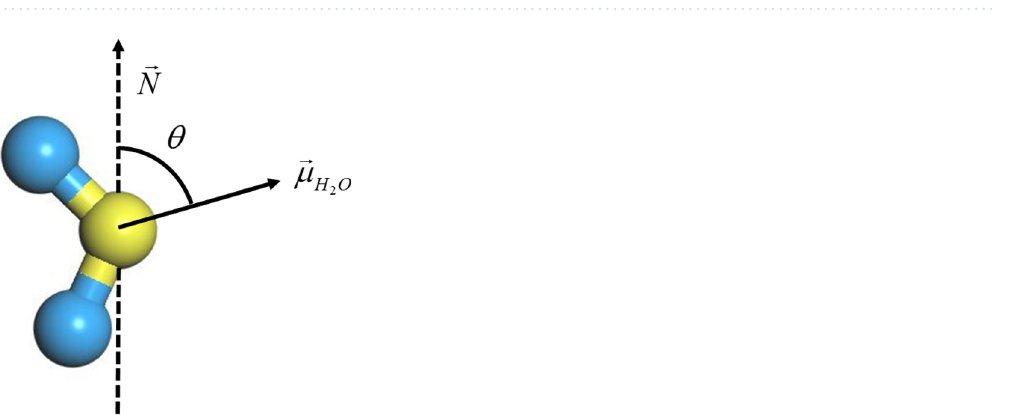
Figure 5. Out-of-plane density of water with various NaCl concentrations inside the ( a ) PG and ( b ) GO nanochannels. ( c ) the comparation of pure water density for the two types of channels.